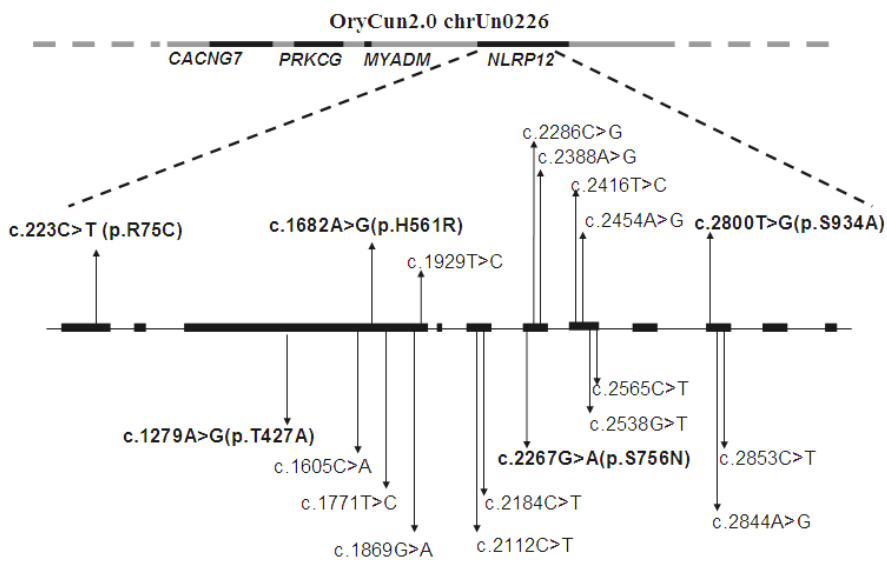
Figure 1. Schematic illustration of rabbit NLRP12 gene characteristic and the identified genetic variants. The relative chromosome positioning of NLRP12 gene was indicated by mapping to GeneBank Scaffold OryCun2.0 chrUn0226. The inverted arrows indicate location of identified variants in the present study, which are numbered by mRNA positions starting from translation initiation codon. Black bars represent the eleven exons. Five variants printed in bold represent non-synonymous mutation, other indicate the synonymous Table 2. The silico functional analysis of the missense mutations in NLRP12 Variant Animo acid change SubPSEC P deletetious P wt P substituted NIC